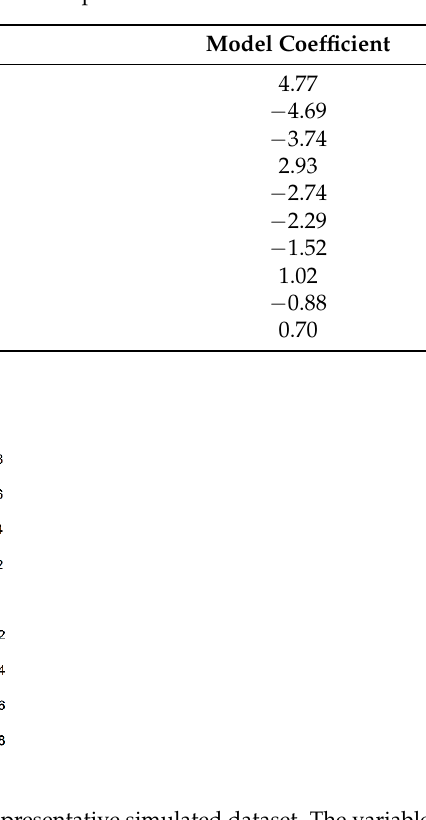
Table 2. Summary of simulated